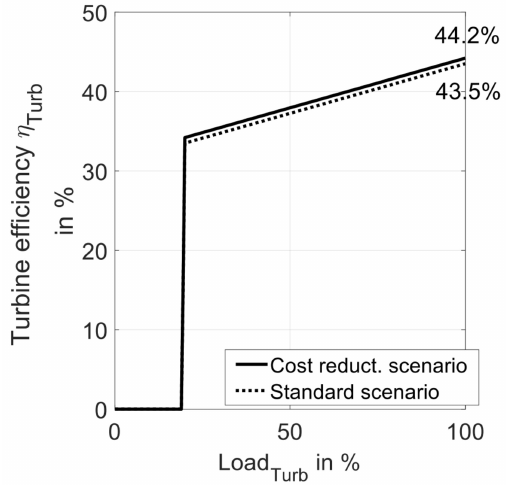
Figure 4. Modelled load dependent turbine efficiency. Values for standard and cost outlook